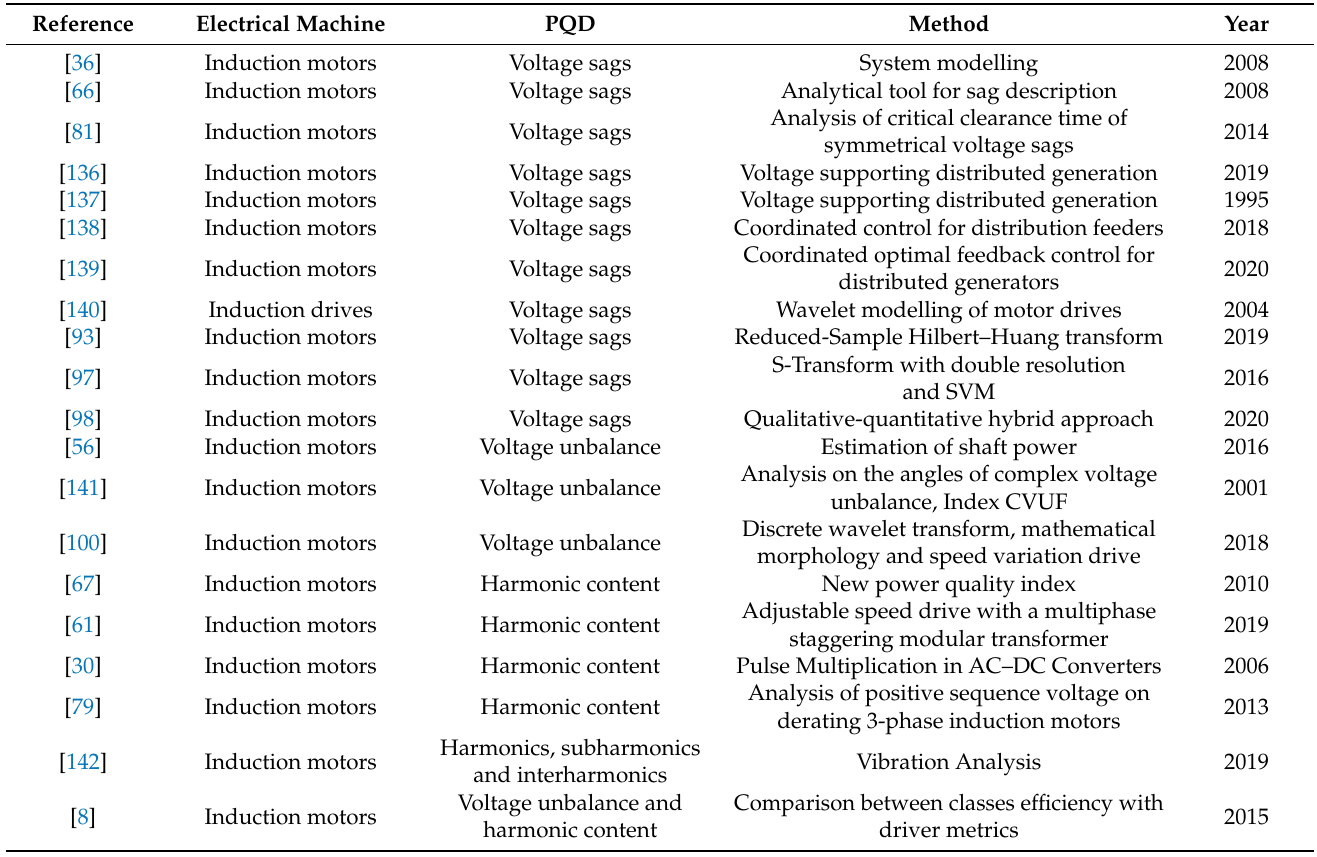
Table 5. Literature dealing with PQDs in electrical machines and